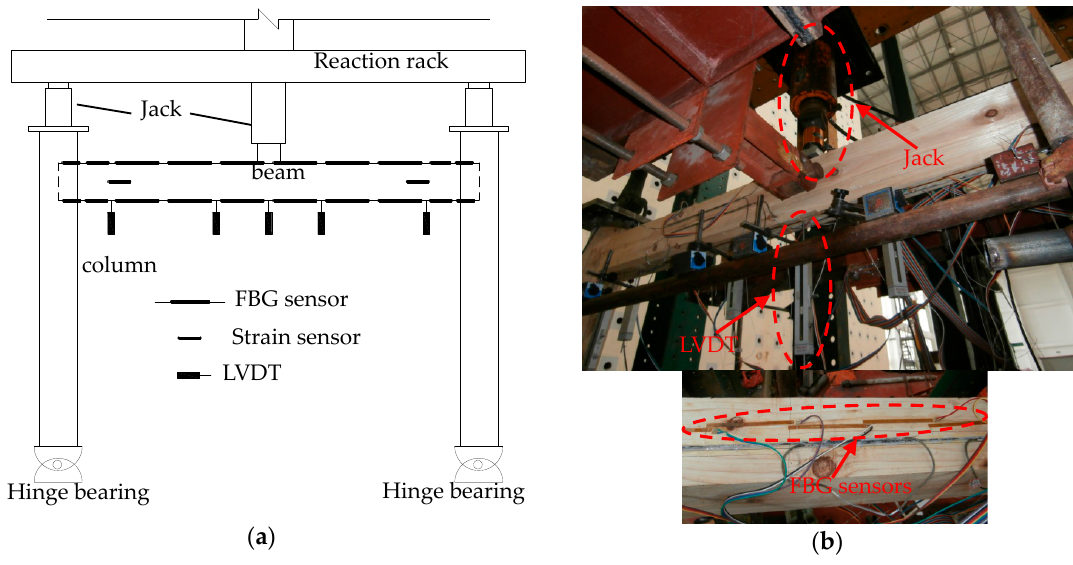
Figure 9. Test setup and layout of sensors: ( a ) Setup and layout of measurement points; ( b ) Photos of sensor layout.